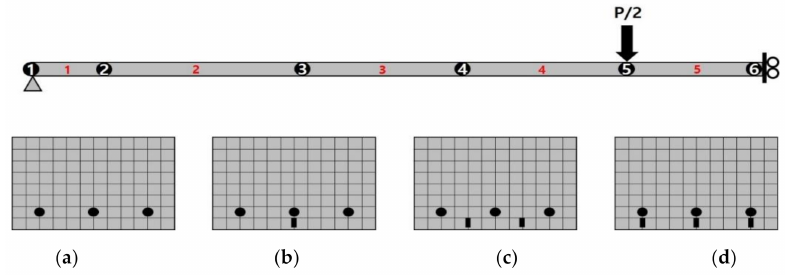
Figure 3. A half of the FE model for RC beams strengthened by Fe-SMA strips: ( a ) SL-CTRL; ( b ) SL-30S-4; ( c ) SL-60S-4; ( d )